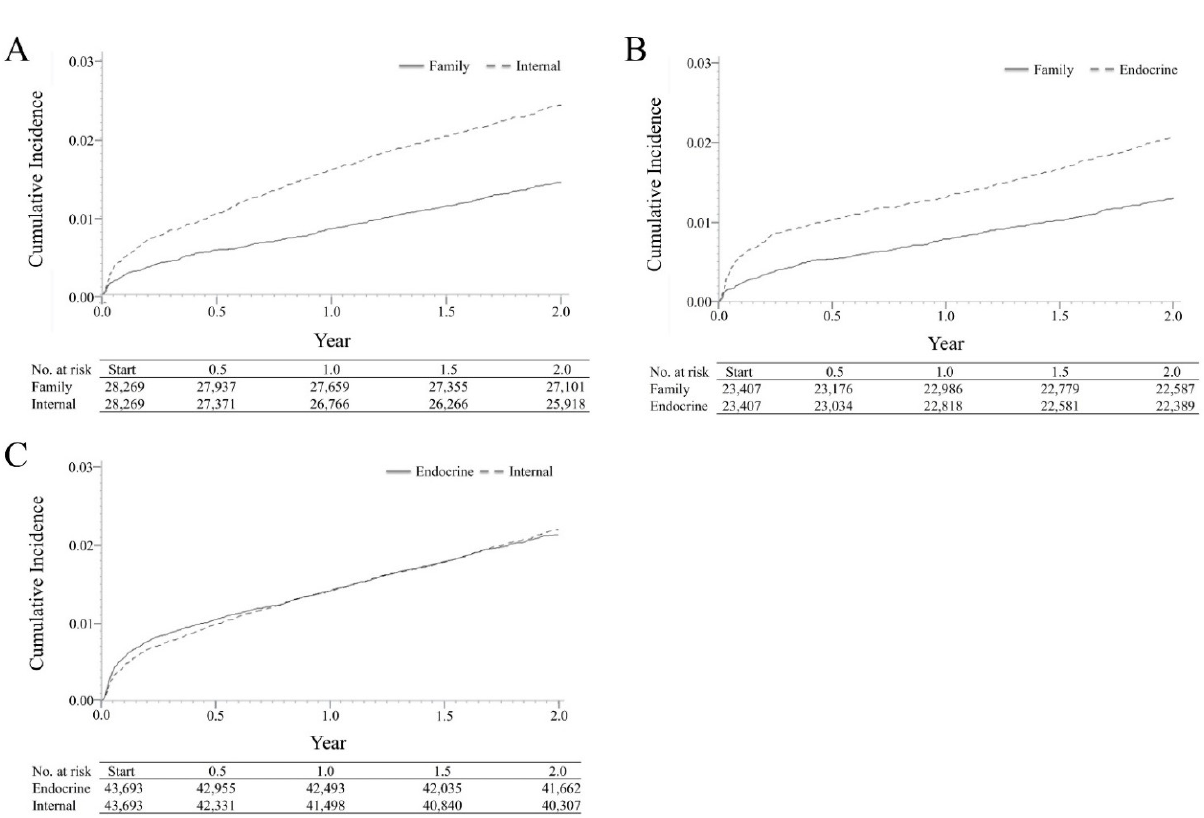
Figure 2. Cumulative Incidences of Acute Complications. ( A ) Family medicine and other internal medicine cohorts. ( B ) Family medicine and endocrinologist cohorts. ( C ) Other internal medicine and endocrinologist cohorts. The survival curves of cumulative incidence risks of acute complications for the FM, IM, and endocrinology cohorts were compared in pairs using the log-rank test. ( A ) Trends revealed that the cumulative incidence risks of developing acute complications in the IM cohort were greater than those in the FM cohort over time. ( B ) Cumulative incidences of acute complications in the FM cohort were lower than those in the endocrinologist cohort over time. ( C ) Trends revealed that the cumulative incidence of risks of developing acute complications in the endocrinologist cohort seemed greater initially but became lower than that in the IM cohort